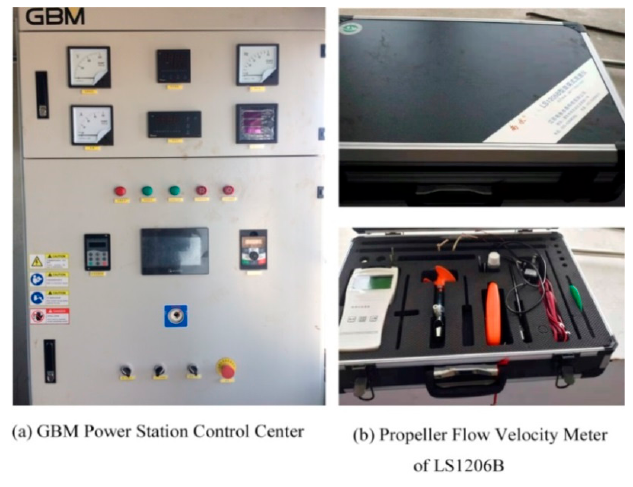
Figure 4. Test devices.